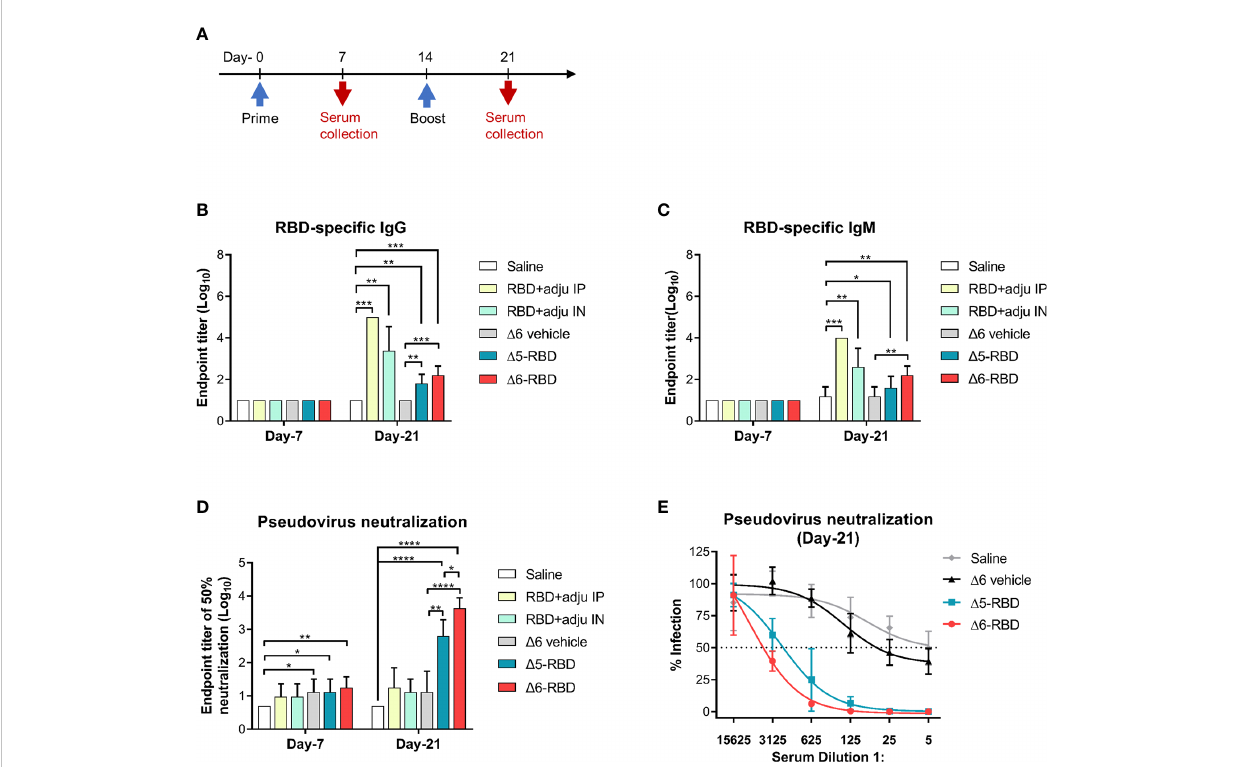
FIGURE 2 Characterization of aPA-RBD induced humoral immune response. (A) A prime-boost vaccination regimen was performed. Mice (n =5 per group) were immunized intranasally with 5 × 10 7 CFU of the aPA-RBD vaccines ( D 5-RBD and D 6-RBD) as well as the D 6/pExoS 54 F ( D 6 vehicle) at days 0 and 14. 10- m g of recombinant RBD protein, with curdlan as adjuvant, was given intranasally (RBD+adju IN) or intraperitoneally (RBD+adju IP) as the RBD controls. Saline was given as sham control. Sera were collected 7 and 21 days after fi rst immunization and assessed for speci fi c antibody against SARS-CoV-2 Spike-RBD. (B, C) Anti-RBD IgG and IgM titers. Comparisons were performed by Student ’ s t -test (unpaired, two-tail); Error bars represent SD. *, P < 0.05; **, P < 0.01; ***, P < 0.001; ****, P < 0.0001. (D) Neutralization potency of aPA-RBD. Five-fold serial dilutions of immune serum from immunized mice was assessed for neutralizing and inhibiting the infectivity of SARS-CoV-2 pseudovirus. Pseudovirus neutralization assay shows the 50% neutralization titer (NT 50 ). (E) Pseudovirus neutralization assay of Day-21 sera. The y-axis corresponds to observed percentage of pseudovirus infection in HEK293 cells that express human ACE2. The horizontal dashed line denotes 50% infection. The x-axis corresponds to reciprocal serum